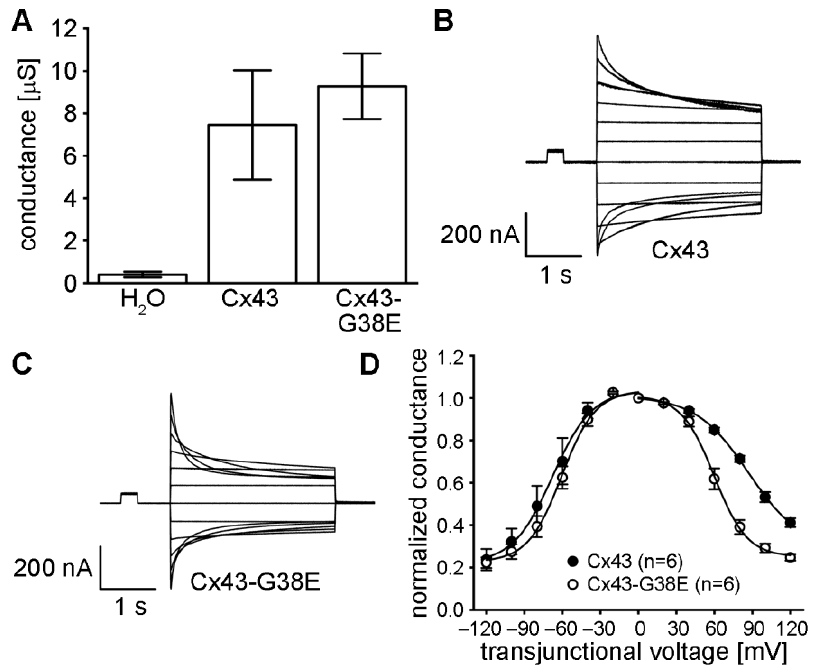
Figure 5. Cx43-G38E forms gap junction channels with altered voltage gating. ( A ) Gap junctional conductance was measured between Xenopus oocyte pairs injected with water (n = 16), wild-type Cx43 (n = 17), or mutant Cx43-38E (n = 22). Both wild-type and mutant Cx43 expressing cells were coupled at significantly greater values than the water injected controls ( p < 0.05, one way ANOVA), but were not significantly different from each other ( p > 0.05, t -test). ( B ) Wild-type Cx43 gap junction channels had junctional currents that decreased asymmetrically at higher trans-junctional potentials. ( C ) Junctional currents between cell pairs expressing Cx43-G38E displayed a more symmetrical decline. ( D ) Steady-state voltage gating of wild-type Cx43 (filled circles) showed an asymmetric decline in steady state conductance at increasing values of transjunctional voltage. Cell pairs expressing Cx43-G38E (open circles) had a more symmetrical reduction in conductance. Solid lines are Boltzmann fits of the data whose parameters are listed in Supplemental Table S1. Data are plotted as the mean ± SE.